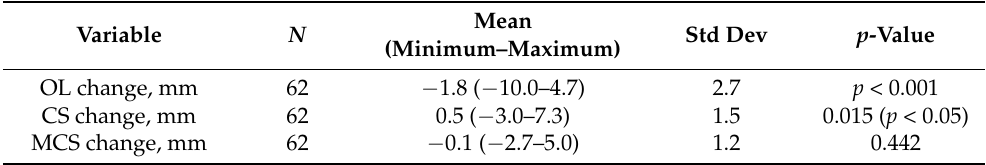
Table 3. Differences in radiographic outcomes for the pre-SR period.